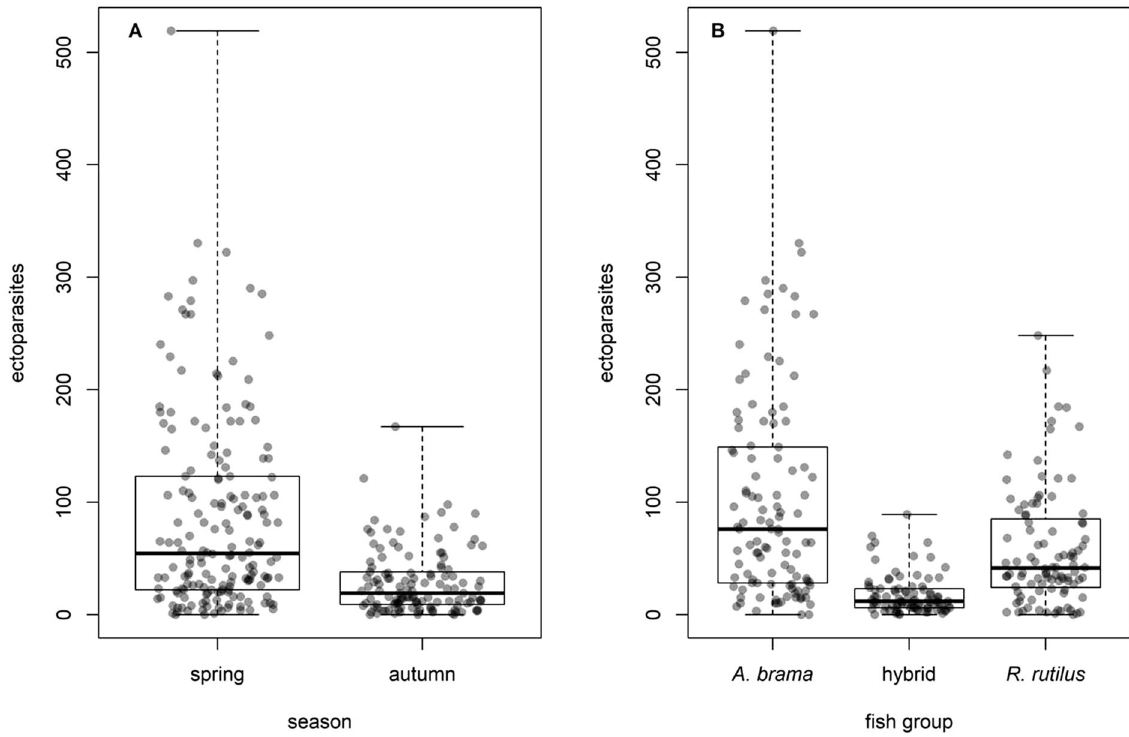
Figure 5. Effects of season ( A ) and fish group ( B ) on ectoparasite